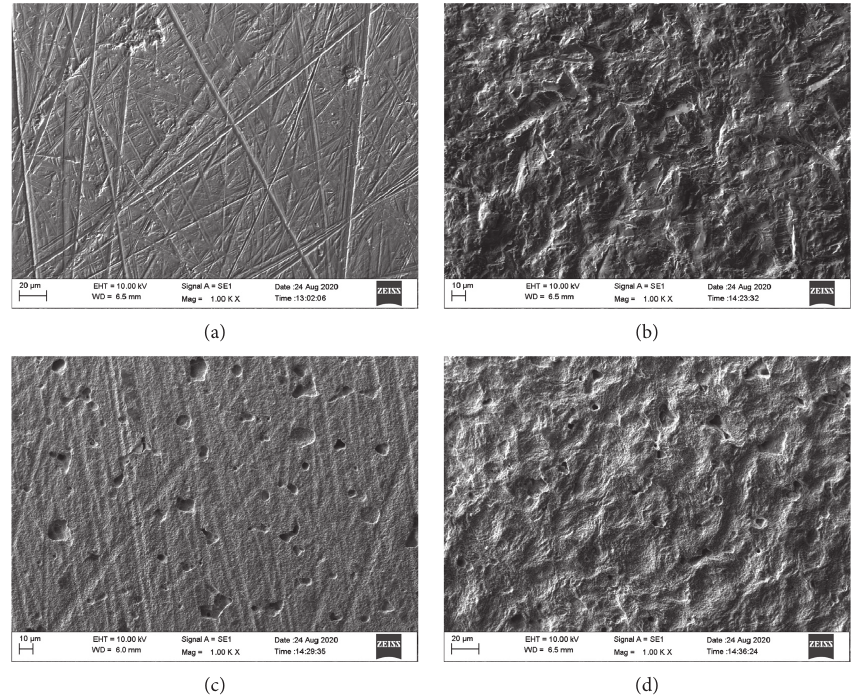
Figure 4: SEM images obtained from each experimental group (Original magnification 1000x). (a) Group OC, (b) Group OA, (c) Group OE, and (d) Group